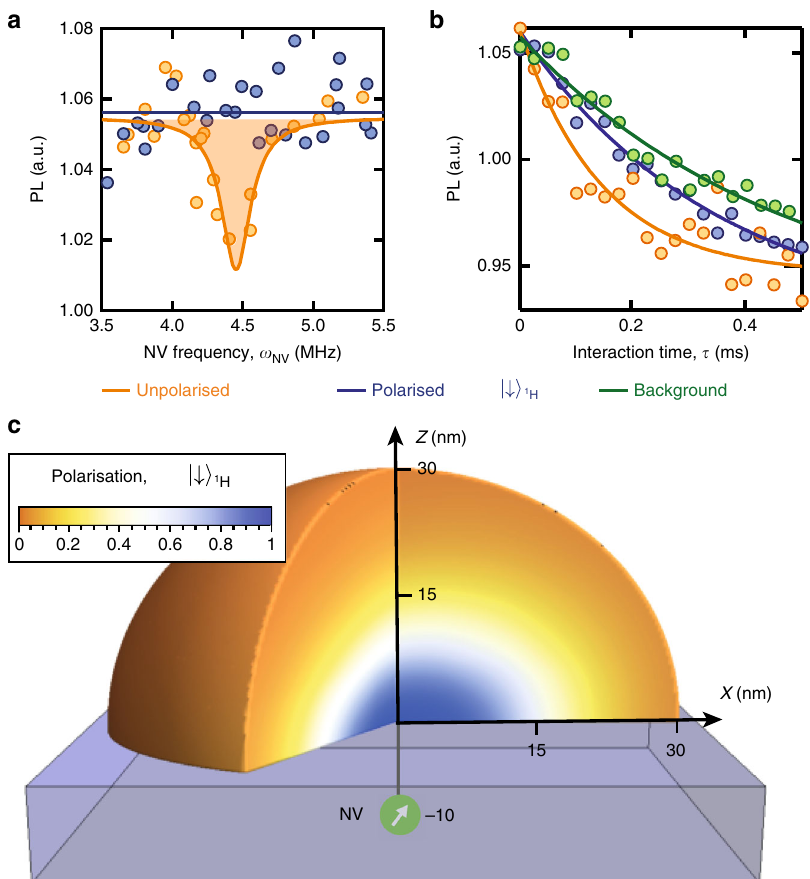
Fig. 3 Polarisation of external molecular 1 H spins. a Cross-relaxation spectra near the 1 H resonance ( ω NV = 4.4 MHz), for a single NV spin located 10 nm below a PMMA layer, obtained using τ = 20 μ s and N = 10 5 with the CRIP sequence (blue) and the depolarisation sequence (orange). b Cross-relaxation curves obtained by increasing τ at the 1 H resonance with the CRIP sequence (blue) and depolarisation sequence (orange), and off-resonance to obtain the background relaxation rate (green). c Three-dimensional representation of the 1 H spin polarisation distribution in PMMA on the surface of a diamond (blue block), calculated from Eq. (1) in the steady 13 C resonance peak for interaction times of τ = 4 µs, indicating dashed line). Examination of the spatial polarisation distribution (Fig. 2c, inset, and Fig. 2d) implies a polarisation level of more ef fi cient polarisation of the nearest spins, as compared with the than 99% within 21 nm of the NV, equating to a 6 × 10 6 -fold target prepared using the depolarising sequence. This is con- fi rmed in the cross-relaxation curves as a function of τ (Fig. 2b, inset), where the polarised case shows no evolution of the NV spin state, while the unpolarised case shows coherent fl ip- fl ops between the NV and the 13 C spins.